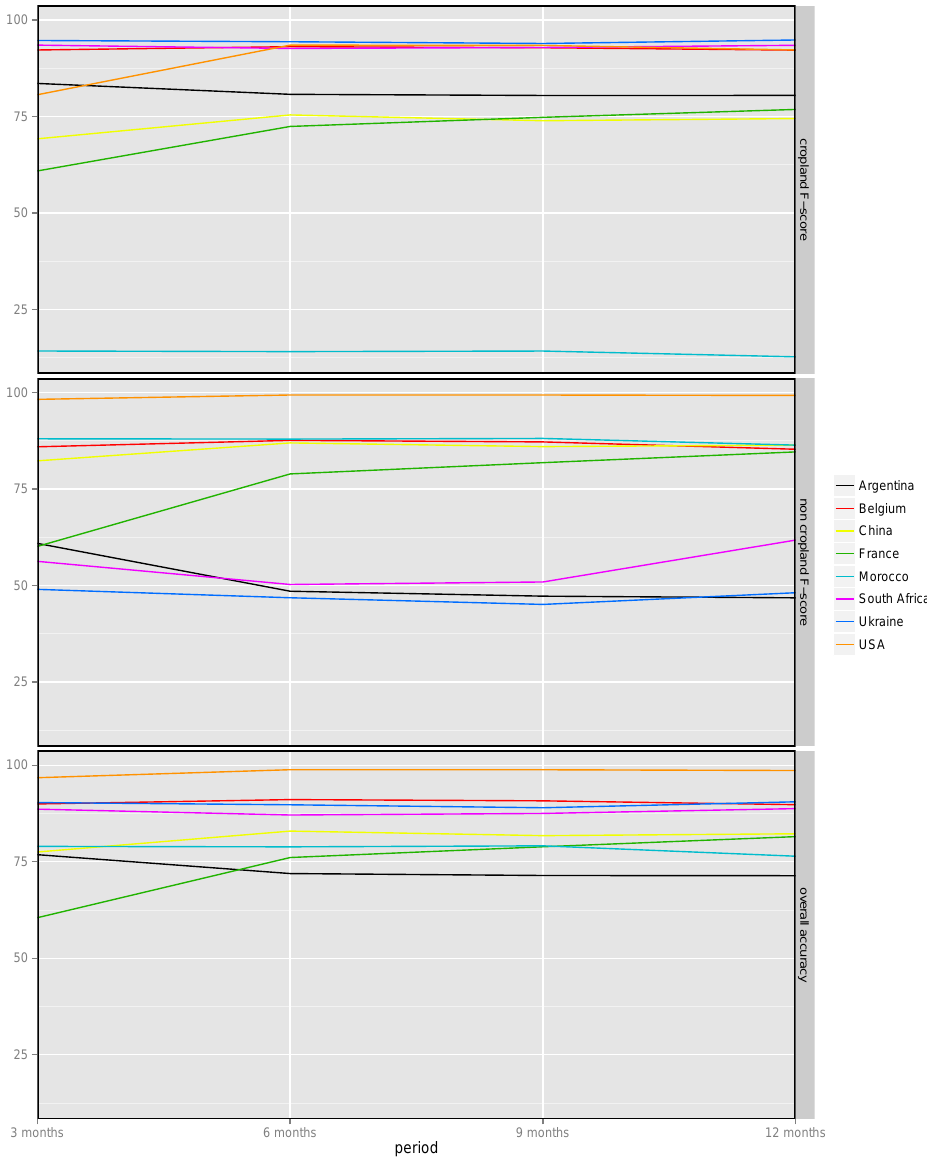
Figure 7. Overall accuracy (OA), F-score for cropland and non-cropland classes as mapped by the maximum likelihood classifier, combined with trimming three, six, nine and twelve months after the beginning of the time